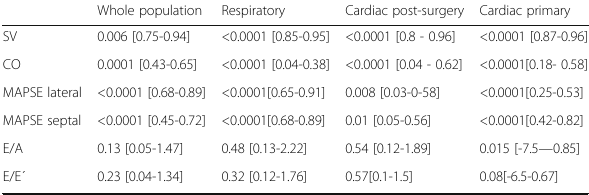
Table 98 (abstract A310). t-IVT correlation with echo&hemodynamic indice